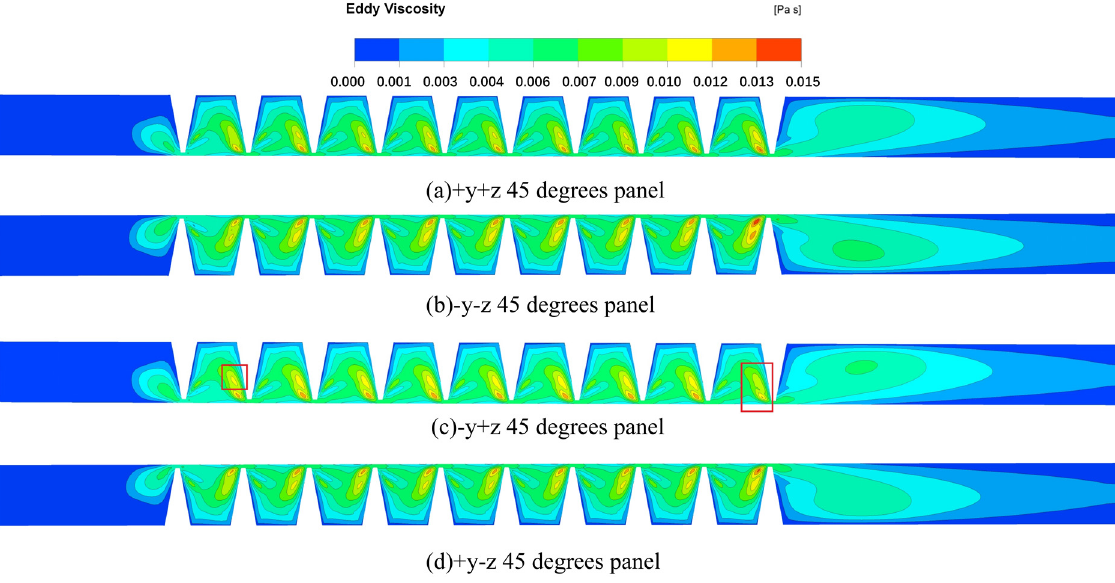
Ω = 50 Hz). Figure 19. Eddy viscosity of HDLS ( ω = 5000 rpm, Ω = 50